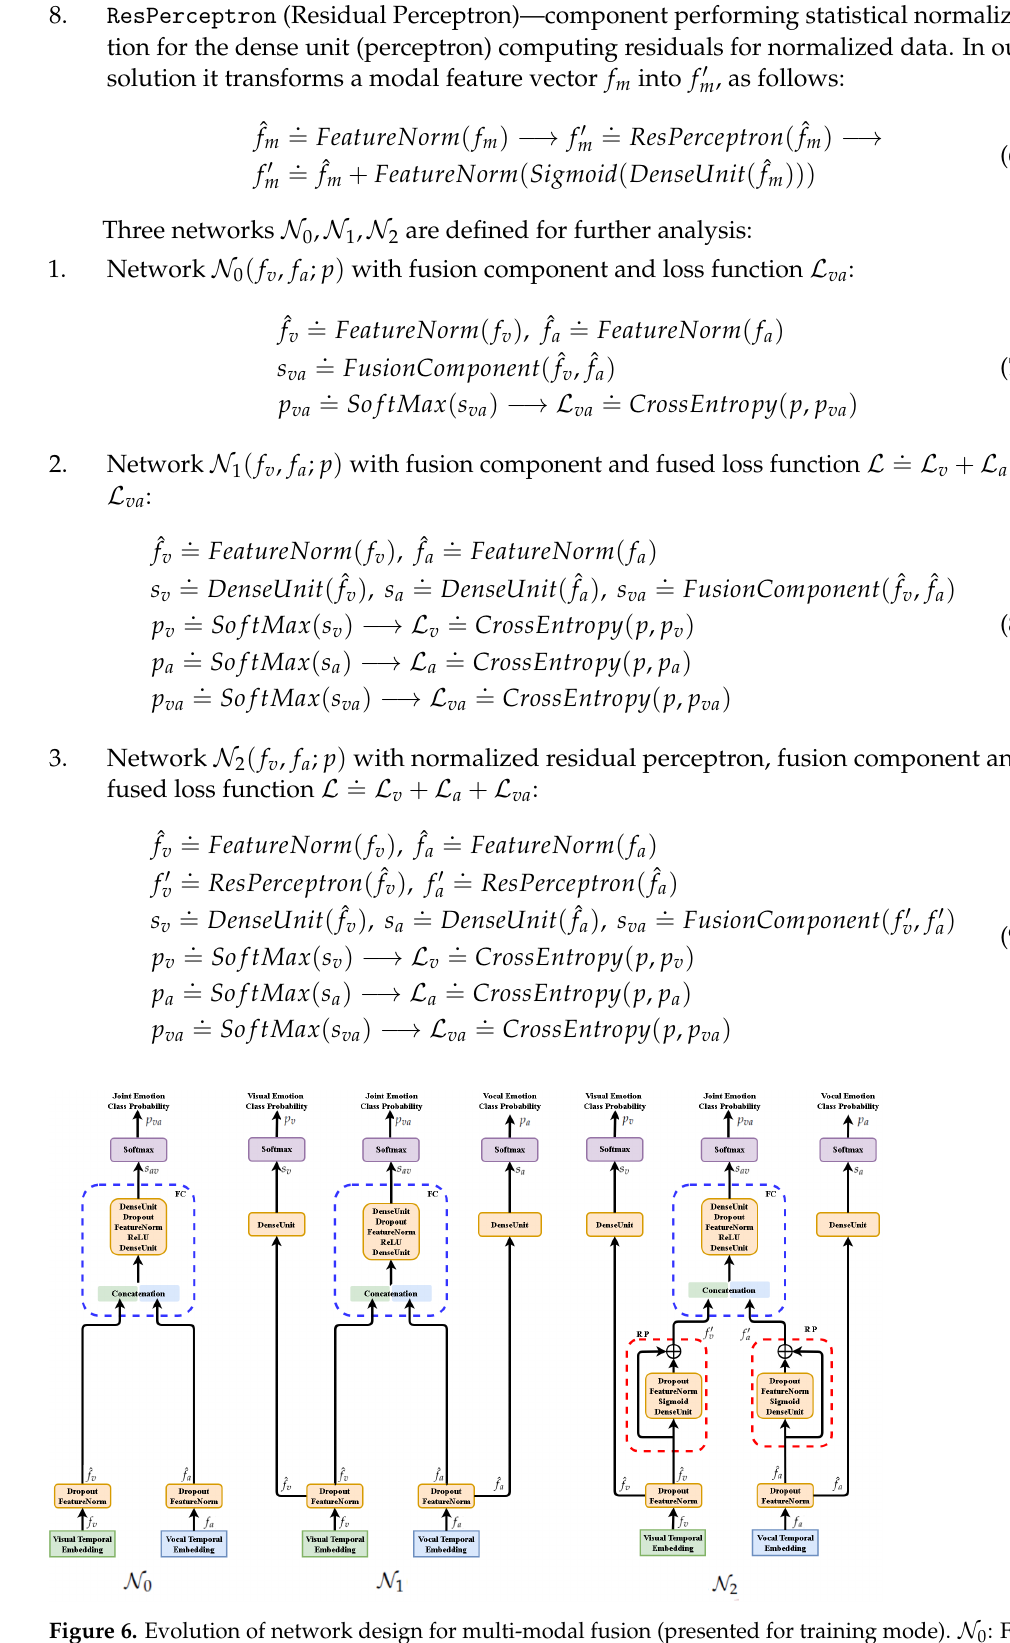
Figure 6. Evolution of network design for multi-modal fusion (presented for training mode). N 0 : Fu- sion component (FC) only. N 1 ([22]): Beside FC, independent scoring of each modality is considered. N N 2 : Extending 1 network by Residual Perceptrons (RP) in each modality